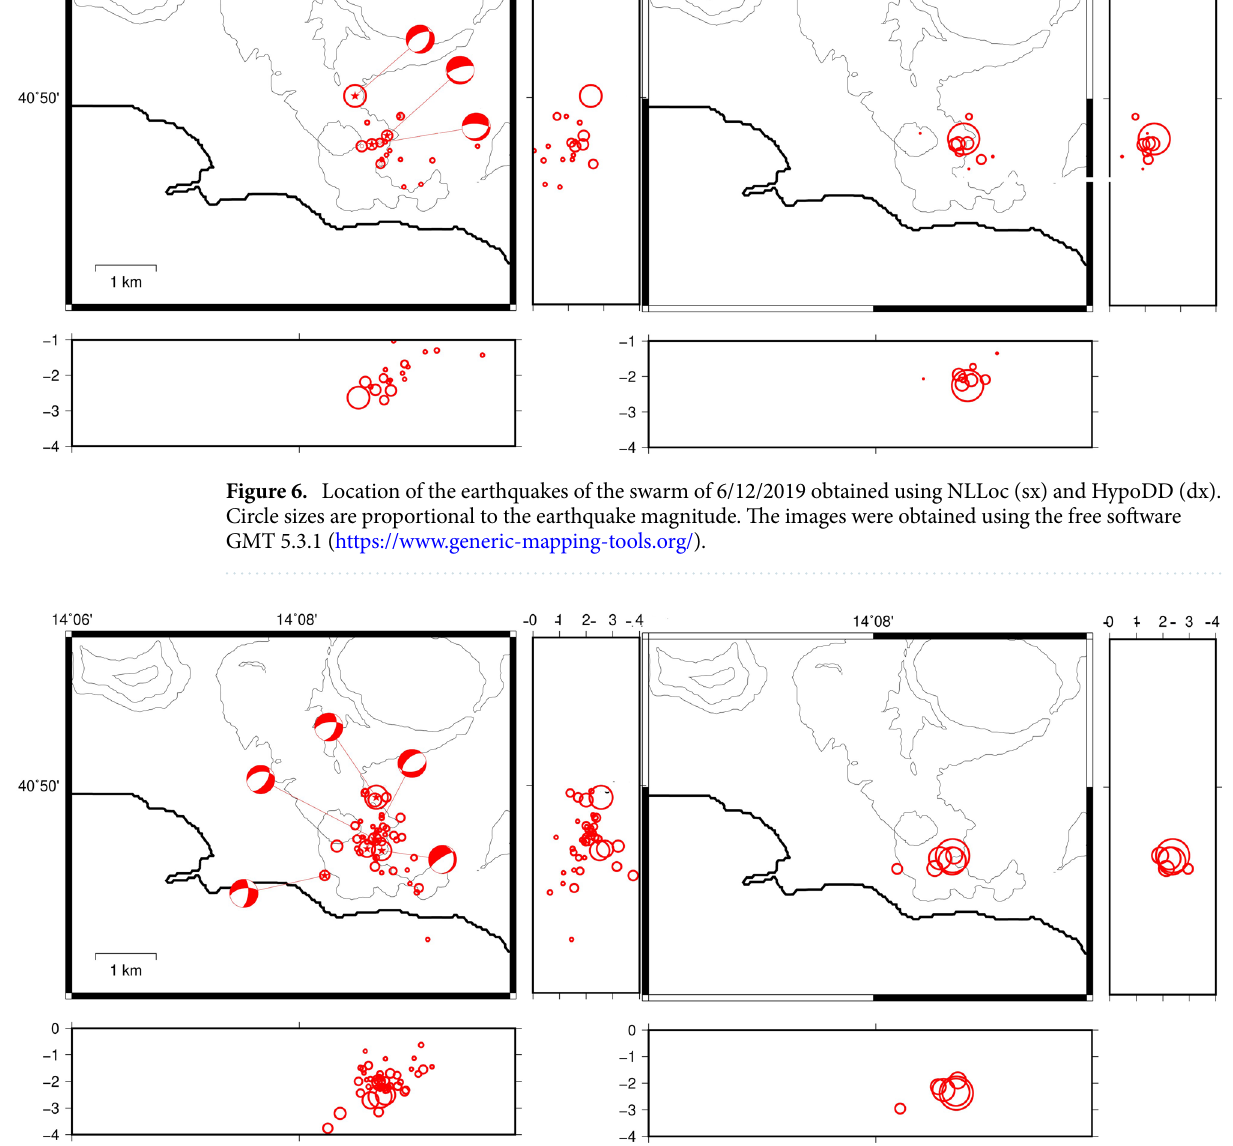
using the absolute locations obtained with NLLoc is wider than the one estimated using HypoDD. The mean horizontal and vertical location errors obtained with the Bayesian approach are ~ 100 m. The focal mechanisms. We analyzed the focal mechanisms of the earthquakes of the most significant swarms recorded since 2000 to evidence any variation in the local stress. We showed beach balls for earthquakes with sufficient azimuthal coverage and with adequate signal-to-noise ratios (usually Md ≥ 1). The rapid occur- rence of earthquakes within a swarm sometimes obscures the first arrivals also for magnitudes higher than 1.5 and increases the picking errors. The obtained focal mechanisms are all congruent (see supplementary Table 1): normal and oriented mostly NE-SW confirming the local extensional trend of the caldera, which is suffering a persistent uplift in its central part. The obtained results confirm what founded by La Rocca and Galluzzo 28 for the events of the seismic cata- logue of Campi Flegrei between 2005 and 2019. The earthquakes belonging to the swarms are all located below the area of Solfatara/Pisciarelli at 2–4 km, except for the 2012 swarm. This swarm was located North of the area